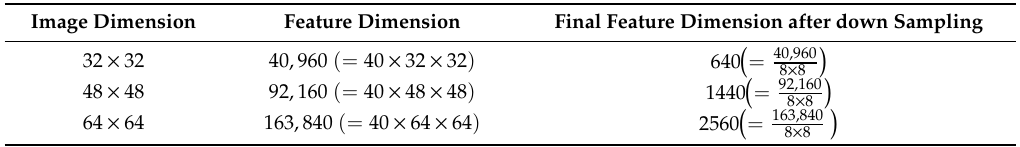
Table 1. Estimation of feature vector size of Gabor filter bank (applied in 8 different orientations and 5 distinct scales) for various image dimensions with a down sampling factor of 8.